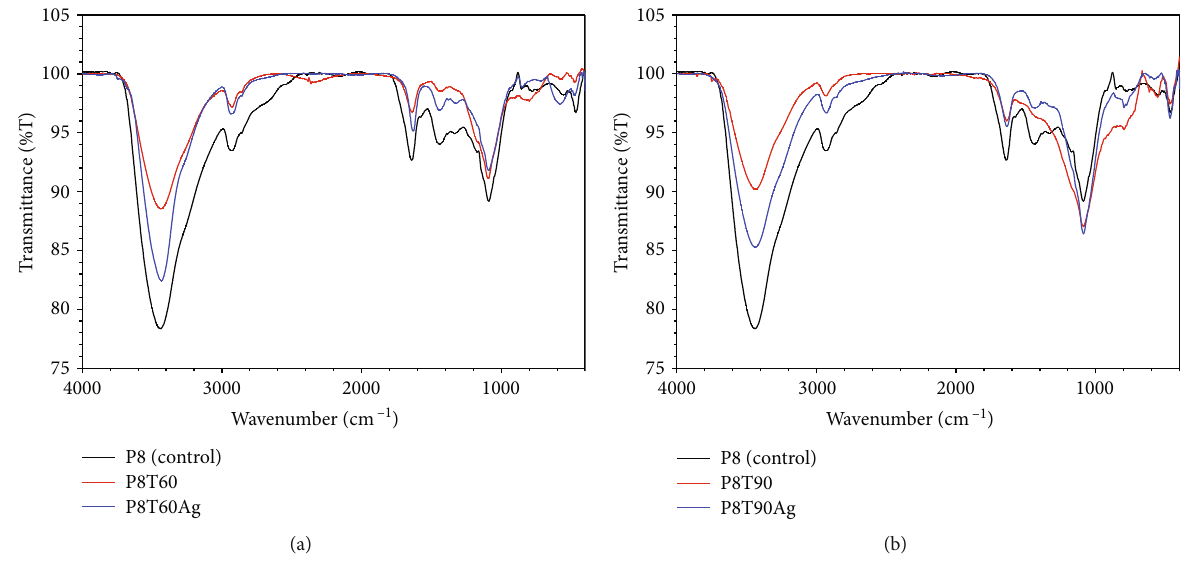
Figure 2: FTIR spectra of (a) P8, P8T60, and P8T60Ag and (b) P8, P8T90, and P8T90Ag.